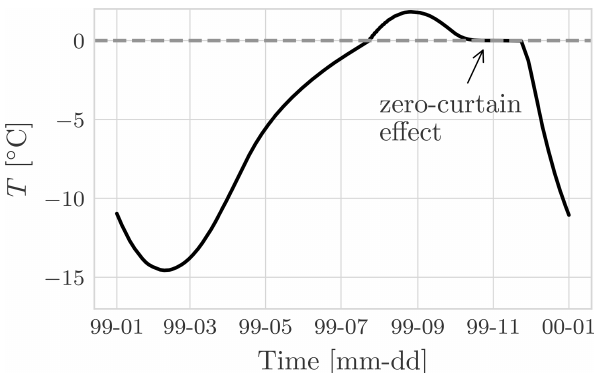
Figure G3. Hourly temperature at 1 . 5m depth for the year 1999. Note the prolonged period of 43d (11 October until 23 November) when temperature remained within ± 0 . 1 ◦ C. This is the so-called zero-curtain effect, and it is due to latent heat of fusion that is con- tinually released during the freezing of soil moisture.